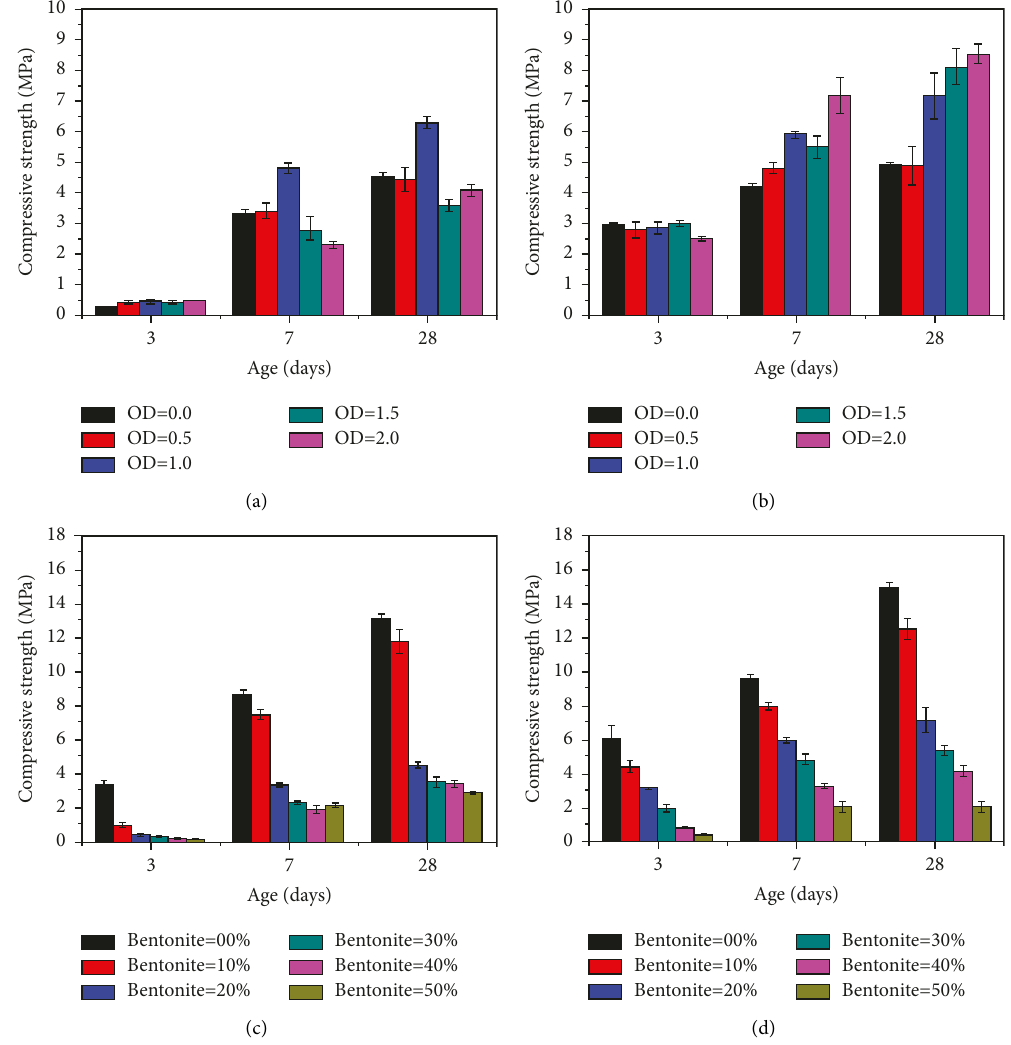
Figure 2: Compressive strength analyses of cement formed with bacterial suspensions of different concentrations (a); different con- centrations of bacterial suspension in the presence of reaction solution (b); different concentrations of bentonite without bacterial sus- pension and reaction solution (c); and different concentrations of bentonite with bacterial suspension and reaction solution